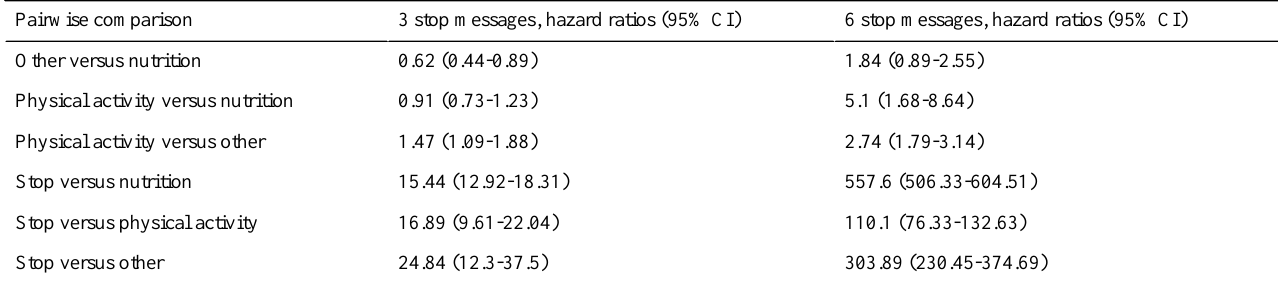
Table 4. Pairwise comparisons by message type for 2 levels of total stop messages